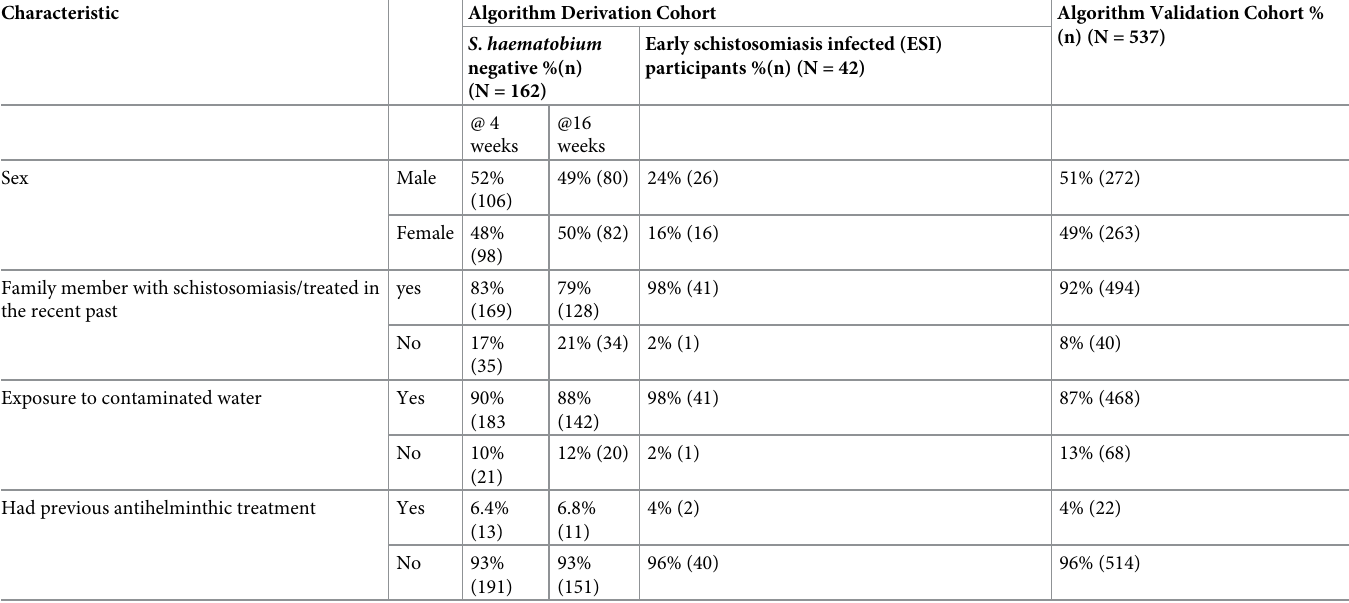
Table 1. Characteristics of Study Participants. Characteristic